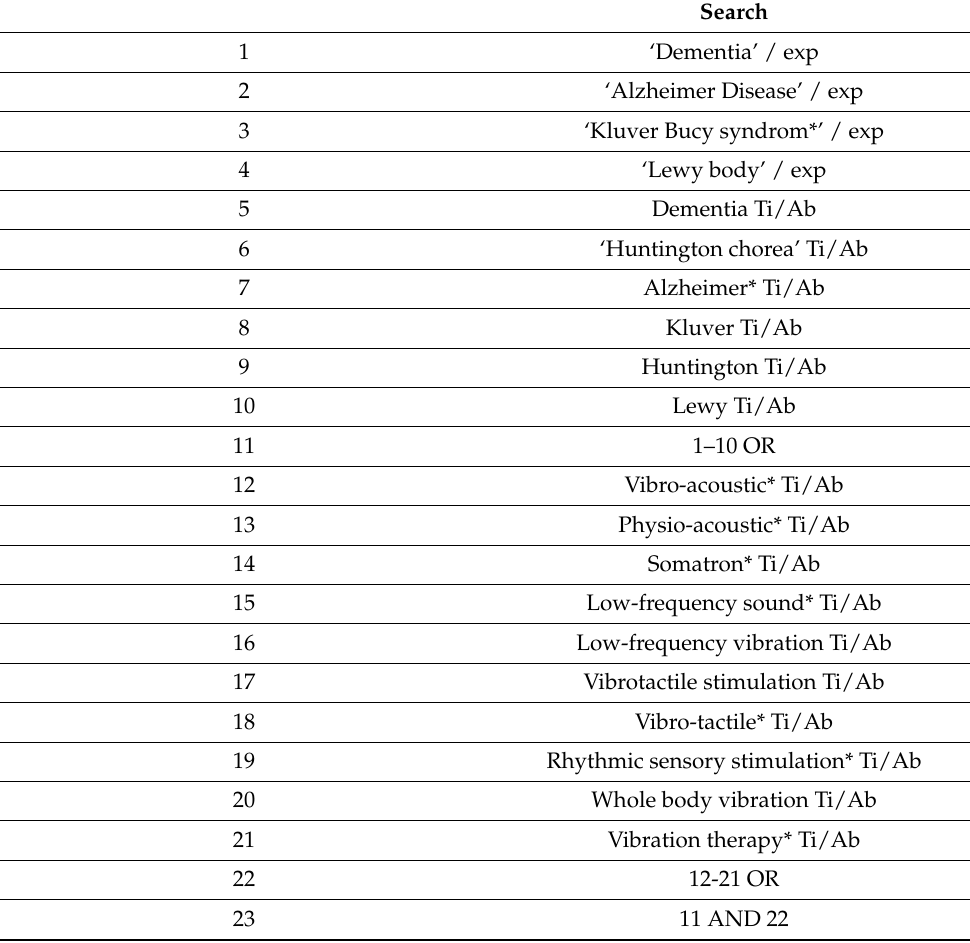
Table A2. Database: EMBASE.